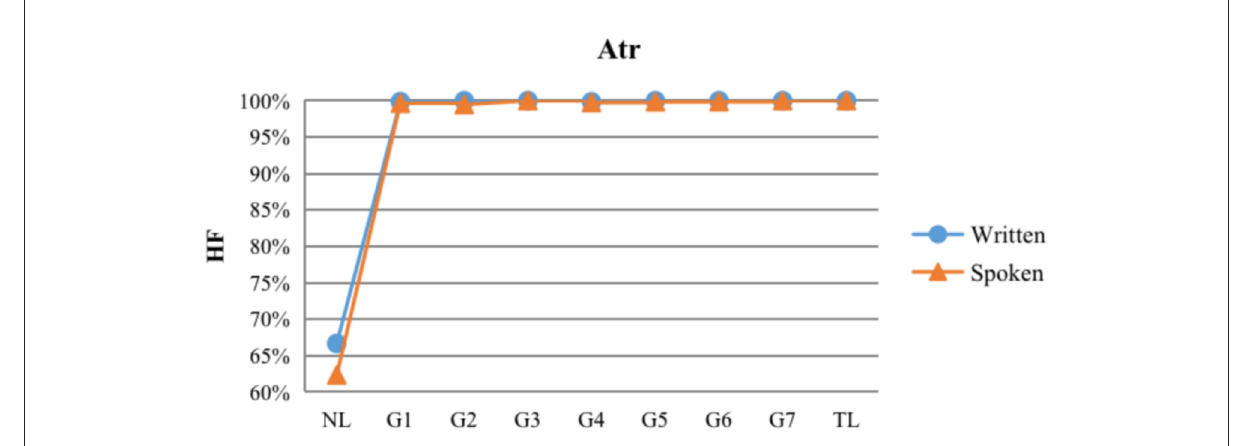
FIGURE5 HF dependency direction distributions of attributives at each level and in contrastive